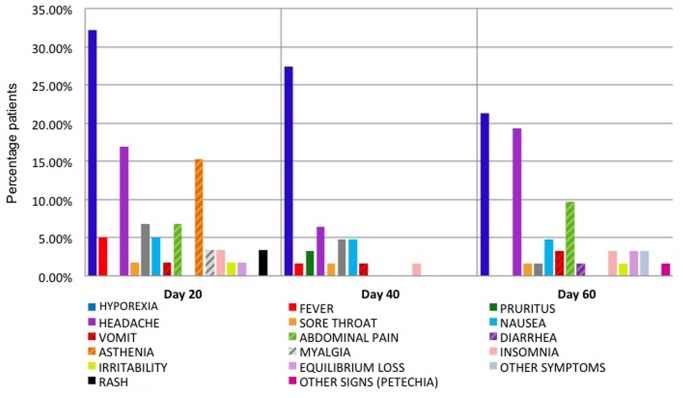
Reported adverse reactions during the treatment with NFX.